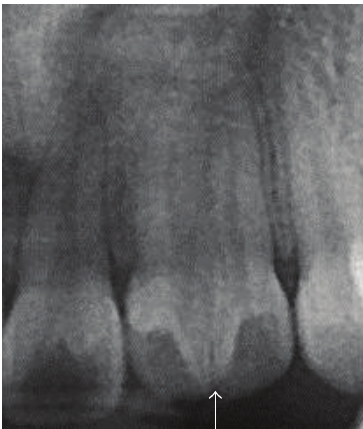
Figure 5: Preoperative radiograph revealing midroot connections between the root canals.